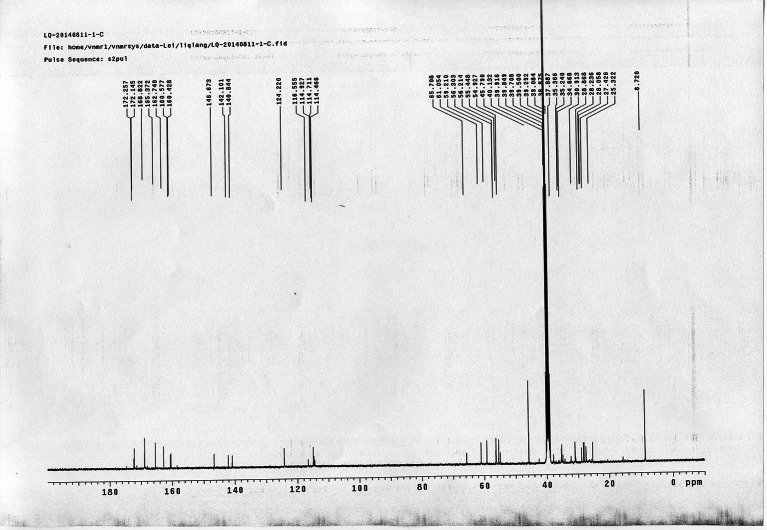
13C NMR spectra of d6-bAL 2.